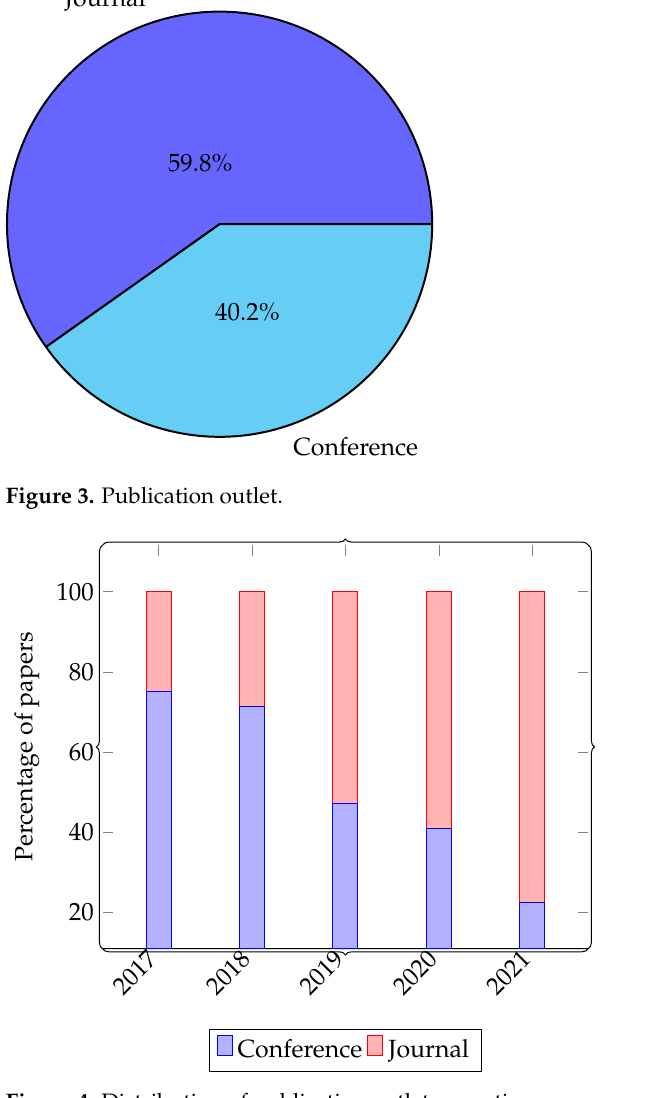
Figure 4. Distribution of publication outlets over